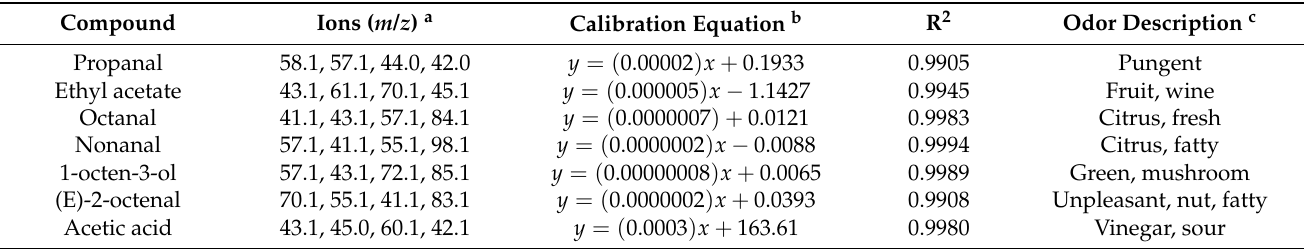
Table 2. Authentic standards, scanned ions, calibration equations, and odor descriptions in the determination of aroma